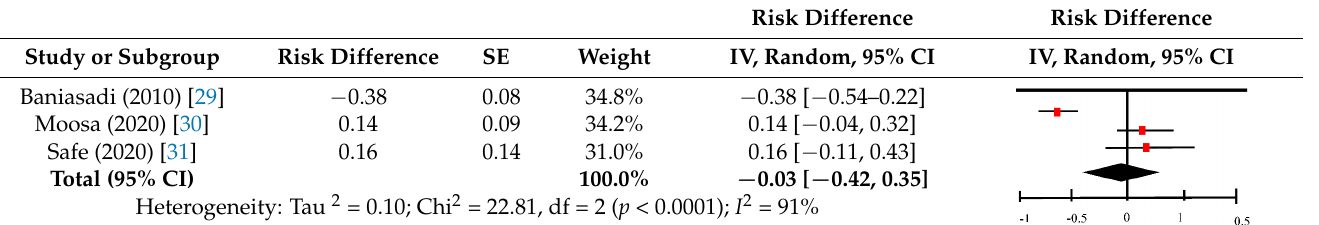
Table 6. Forest plot on adverse